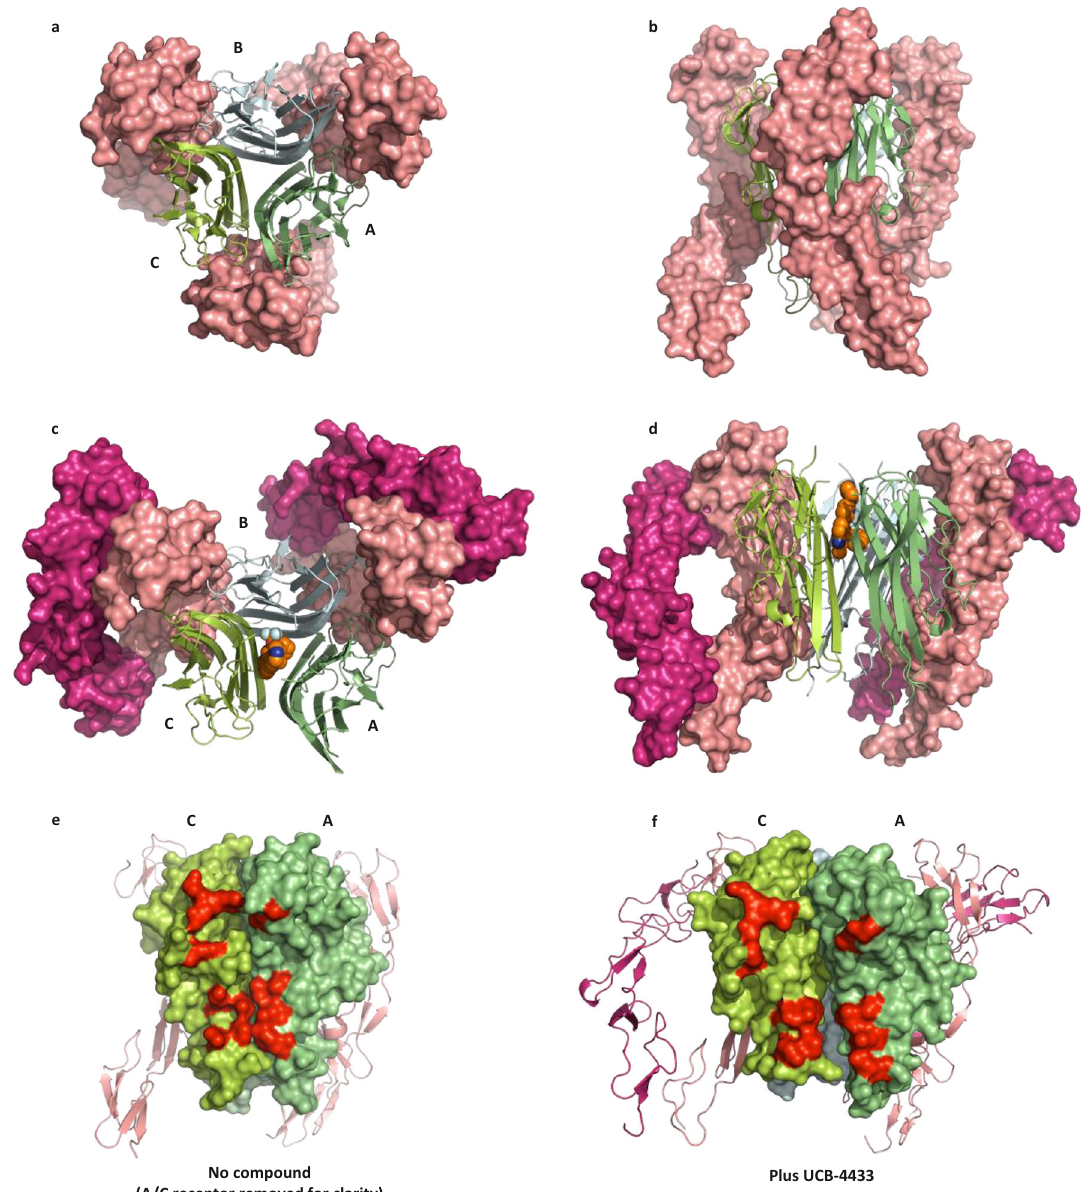
Fig. 2 Comparison of mouse TNF-humanTNFR1 complex with and without compound. Top view ( a ) and side view ( b ) of trimeric mTNF (green ribbons, monomers assigned A, B and C) with three copies of monomeric receptor-bound (pink surface rendered) (PDB: 7KP7 [https://www.rcsb.org/structure/ unreleased/7KP7]). Top view ( c ) and side view ( d ) of trimeric mTNF (green ribbons) with UCB-4433 bound (orange space- fi ll) and two copies of dimeric hTNFR1 bound (pink and purple surface rendered) (PDB: 7KP8 [https://www.rcsb.org/structure/unreleased/7KP8]). e Side view of mTNF (green surface rendered) without compound — one copy of the hTNFR1 has been removed to reveal the non-distorted a – c receptor binding site (selected residues involved in hTNFR1 binding highlighted in red). f Side view of mTNF (green surface rendered) with UCB-4433 bound (not visible) revealing the distorted A – C receptor binding site (selected residues involved in receptor binding highlighted in